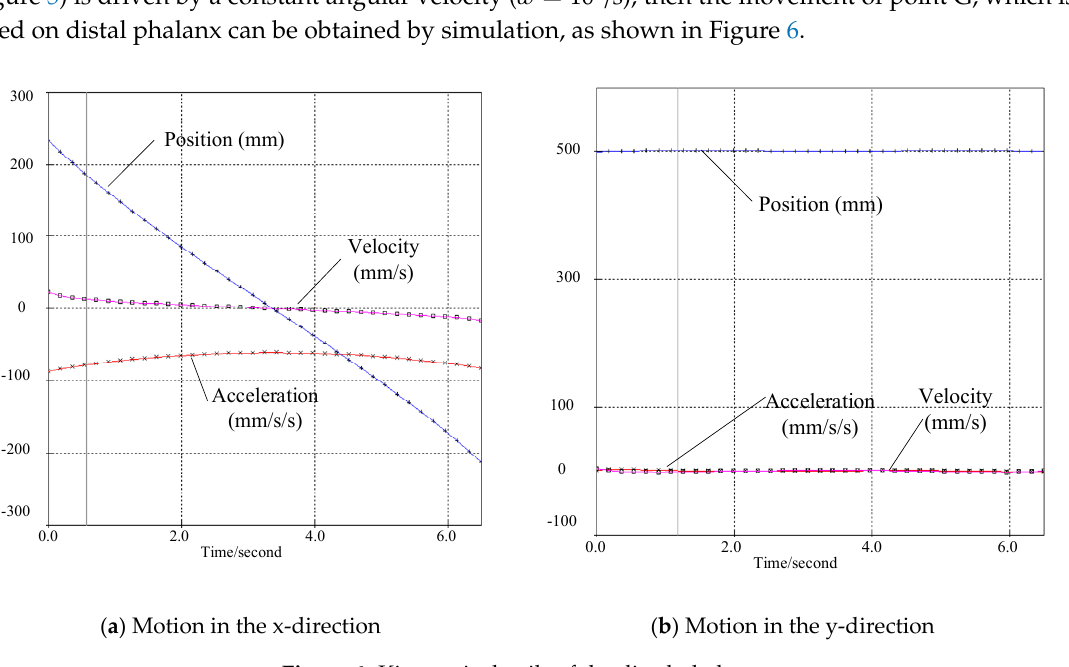
Figure 6. Kinematic details of the distal phalanx.